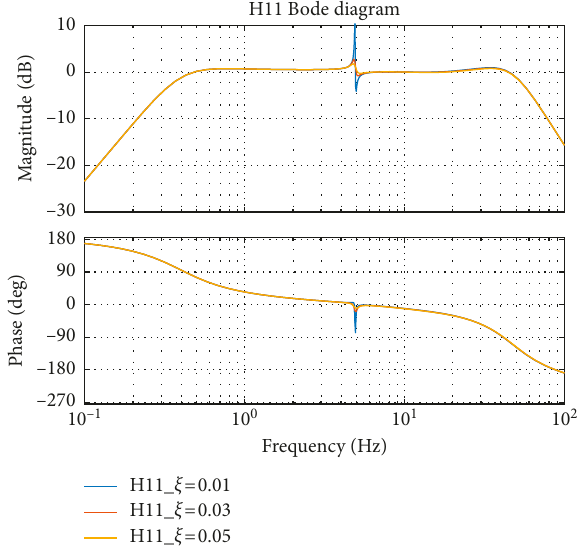
Figure 7: Effect of specimen’s damping ratio on frequency re- sponse of H 11